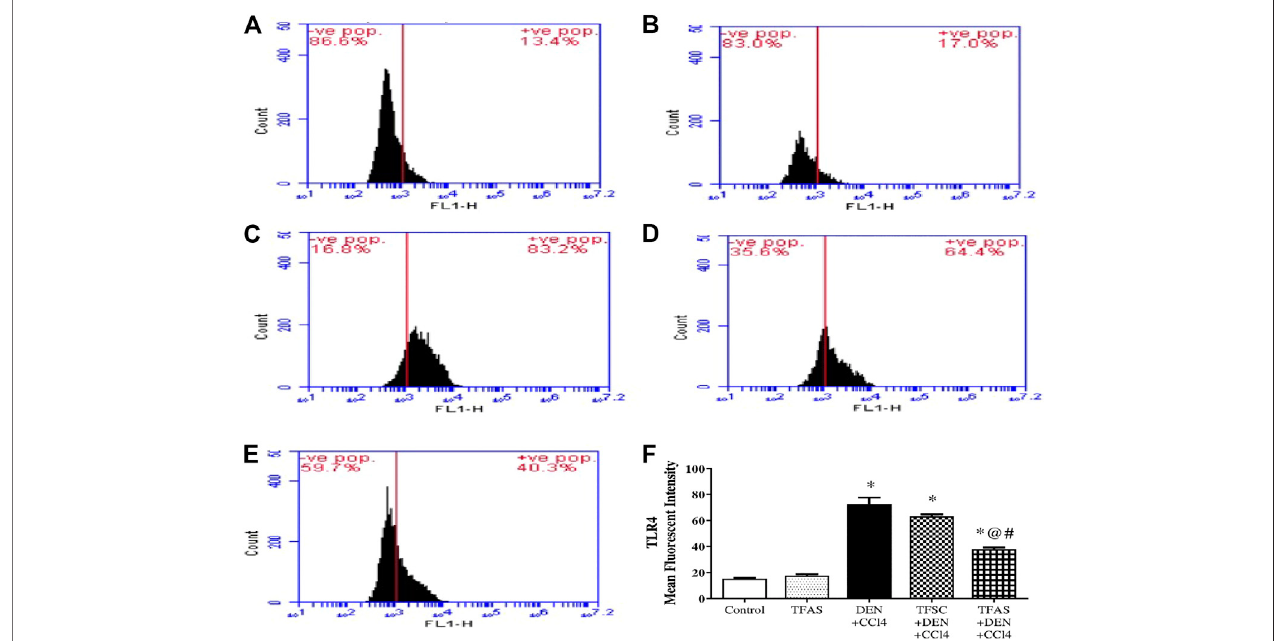
FIGURE7| FlowcytometricanalysisoftheeffectofTF-ODNsonTLR4expressionintheliver.Histogramplotsof (A) Controlgroup, (B) TFASgroup, (C) DEN+CCl4 group, (D) TFSC+DEN+CCl4, (E) TFAS+DEN+CCl4 and (F) Mean fl uorescence intensity of TRL4. Data are expressed as mean ± SEM (n (cid:1) 8). (*), (@) and (#) indicate signi fi cant difference from Control, DEN+CCl4 and TFSC+DEN+CCl4, respectively at P < 0.05 using one-way ANOVA followed by Tukey-Kramer post-Hoc test. TLR4: toll like receptor 4; DEN: N-diethyl nitrosamine; CCl4: carbon tetrachloride; TFSC: scrambled tissue factor oligodeoxynucleotides; TFAS: antisense tissue factor